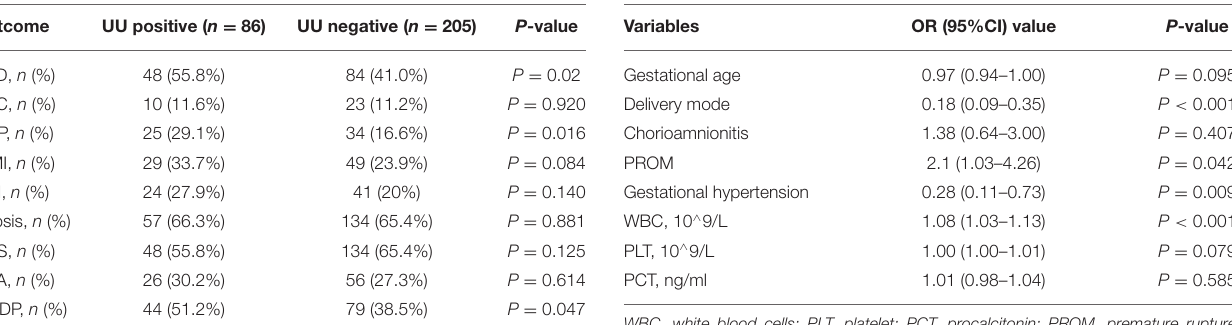
TABLE 3 | Multivariate logistic regression analysis of UU